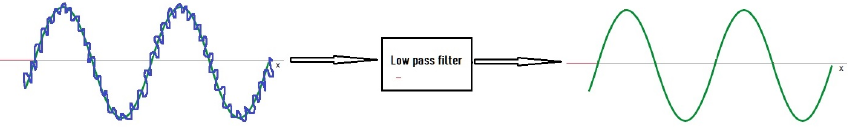
Figure 1. Using a low-pass filter to remove noise from a sinusoidal